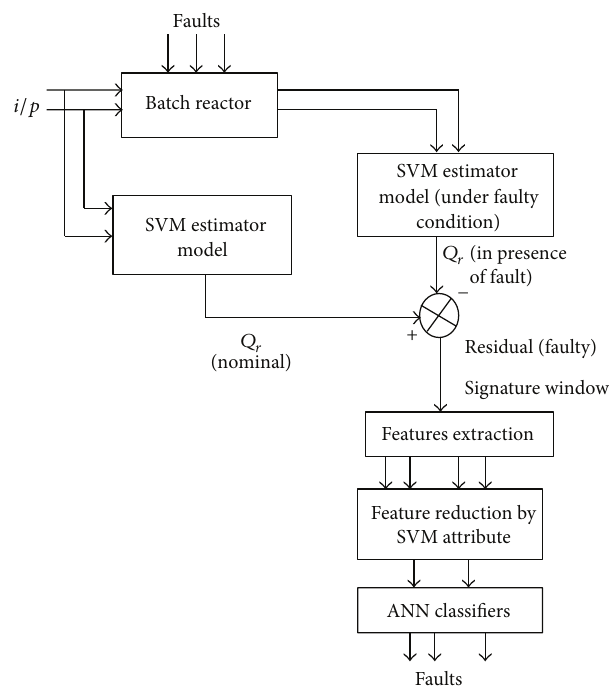
Figure 8: Block diagram of fault diagnosis process. Table 2: Fault description.